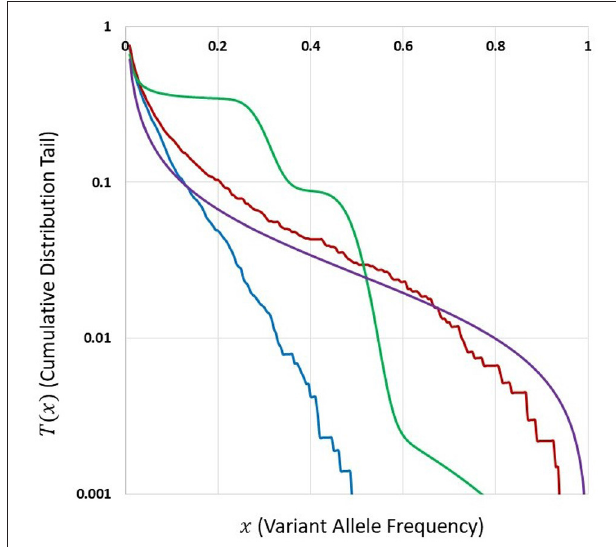
FIGURE 5 | Comparison of cumulative tails in semi-logarithmic coordinates yielded by different theoretical models of cell proliferation, mutation and selection. Blue: Model A. Red: Model B. Both with identical parameters s = 0.5, d = 0.0001, L = 6, p = 0.01, t = 100, and N = 200. Green: Multiclone model of Dinh et al. (2020b), with parameters m = 3, n = 200, A = 40, K 1 = 5, K 2 = 15, P 1 = 0.5, and P 2 = 0.3. Purple: Model of McDonald et al. (2018) , based on a smoothed version of a Figure in Tung and Durrett